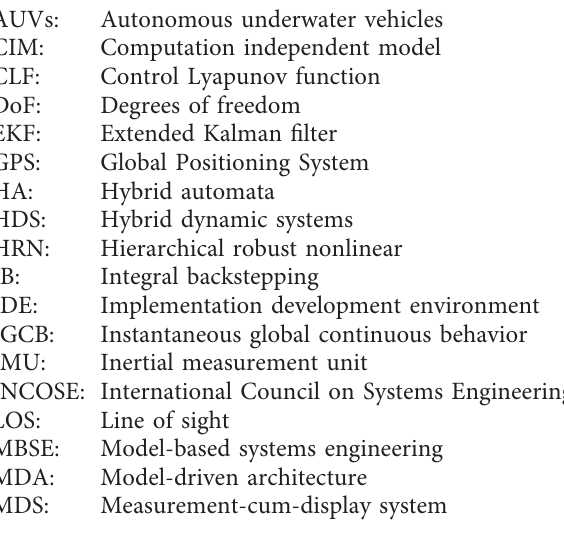
Table 5: Comparison of the path tracking error between the two cases using the EKF and UKF algorithms. Using the EKF algorithm Using the EKF algorithm Paths generated by RMS position error WPs